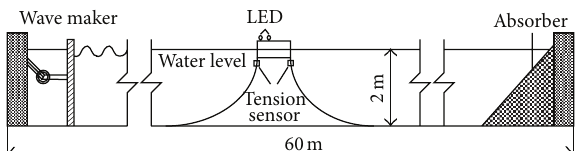
Figure 2: A sketch of model setup in wave